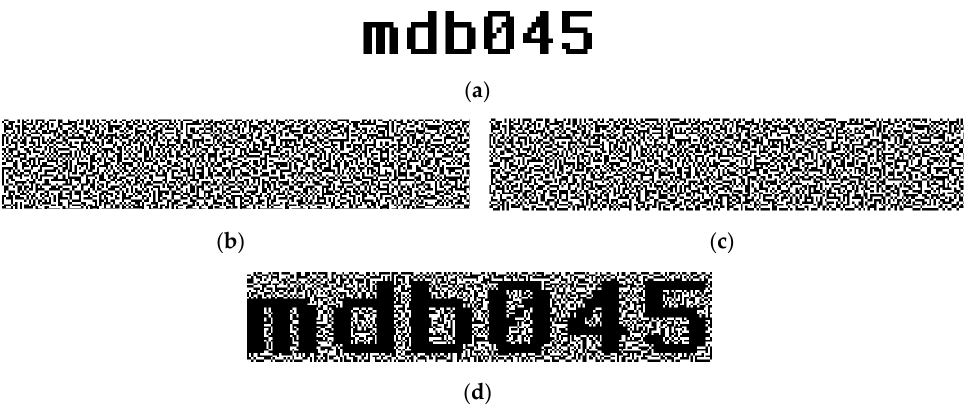
Figure 4. The original patient’s identity (watermark) and its generated secret shares using Shamir’s scheme: ( a ) original identity I , ( b ) first secret share S 1 , ( c ) second secret share S 2 , ( d ) retrieved identity by overlapping (bitwise AND operation) of S 1 and S 2 .